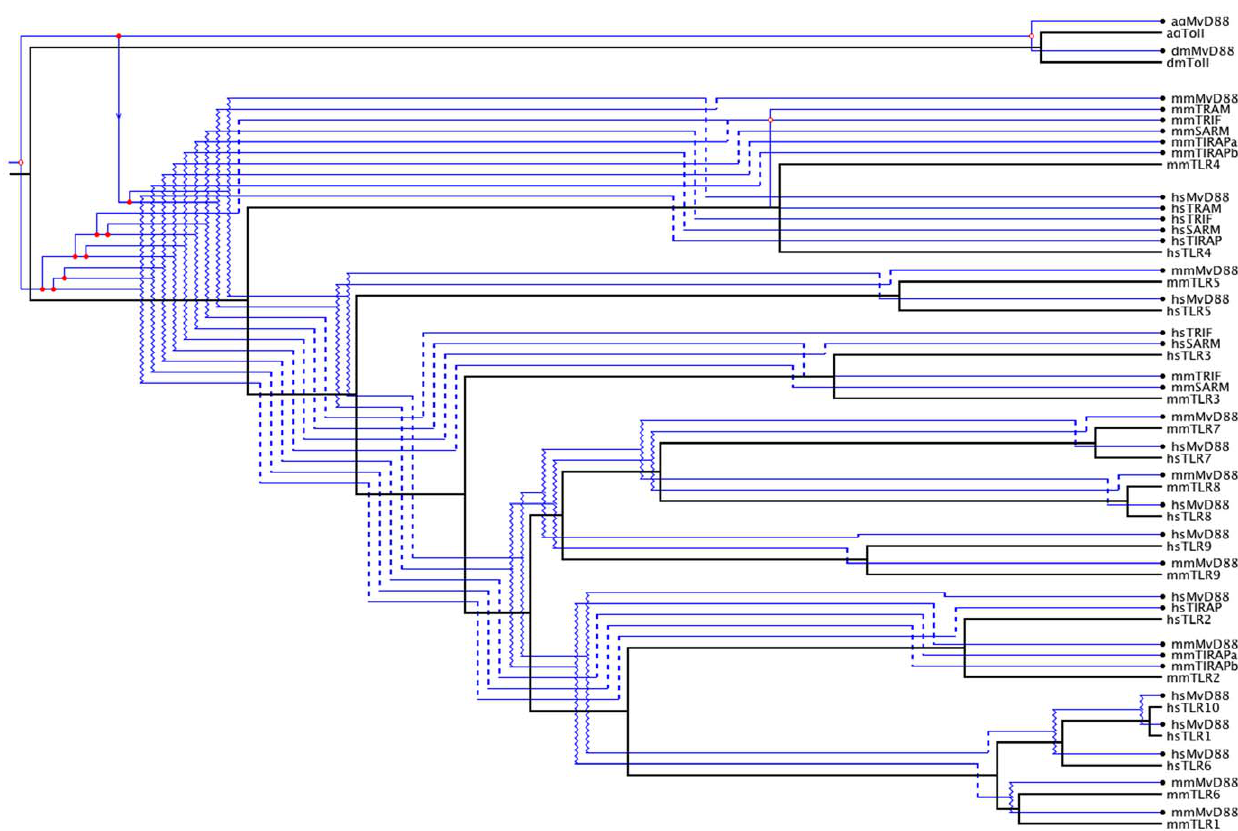
Figure 3. Embedding of the phylogeny of the TIR domain of the adaptor molecules into the phylogeny of the TIR domain of the TLRs for mouse and human shows that early gene duplication gave rise to extant adaptor families and paralleled the diversification of TLRs. Open circles indicate cospeciation events. Closed circles indicate duplication events. Wavy lines indicate failure to diverge and dashed lines indicate loss. Lines with arrows denote "host" switching- the co-option of an adaptor by a different TLR. These data are consistent with the vertebrate MyD88 begin recruited from an earlier invertebrate-like MyD88 that was likely associated with TLR9-like TLRs.